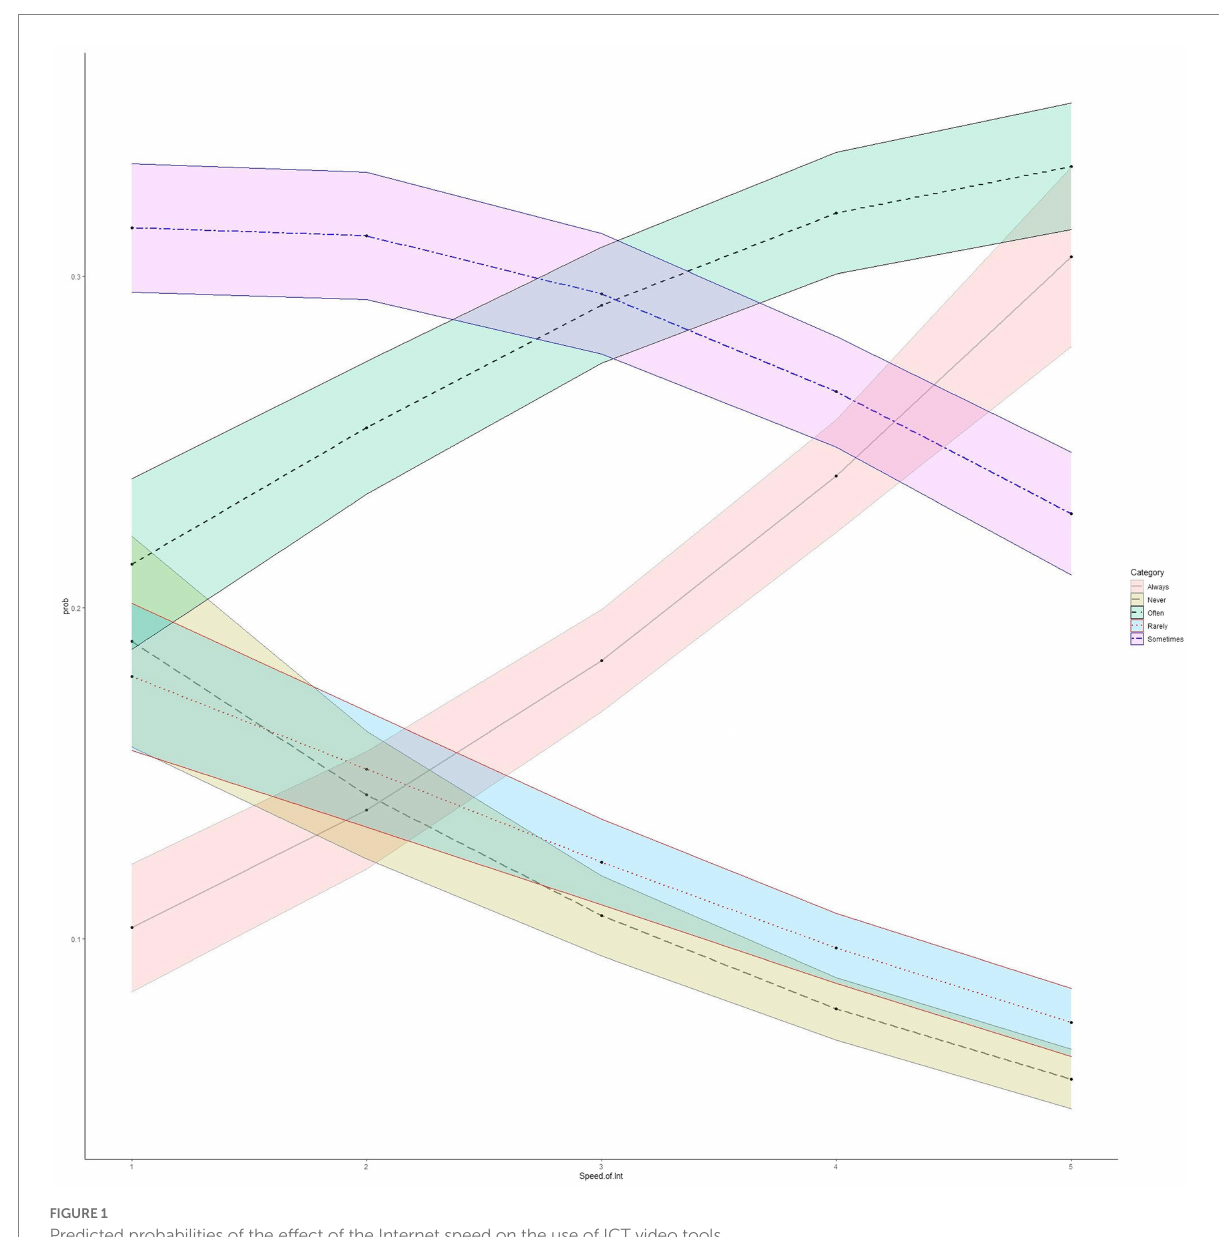
FIGURE 1 Predicted probabilities of the effect of the Internet speed on the use of ICT video